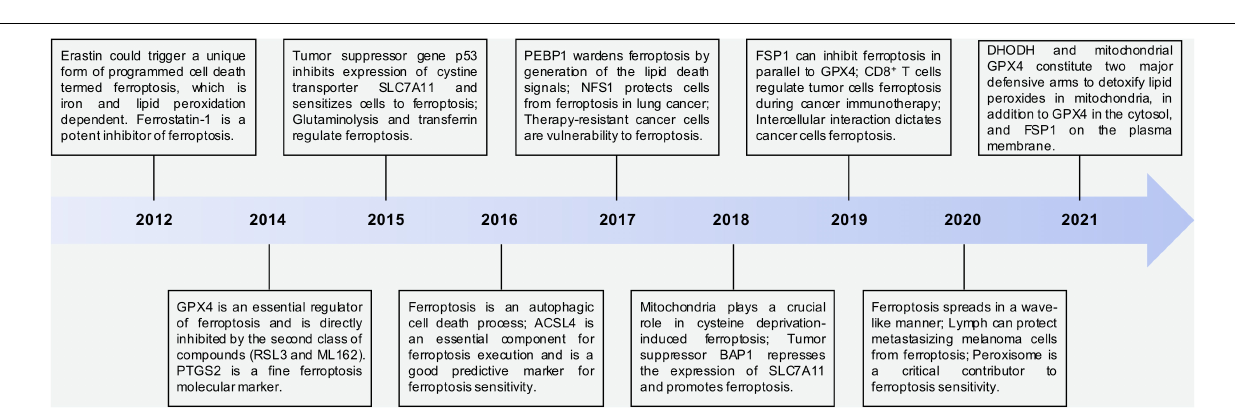
FIGURE 4 | The key points in discovery and research history of ferroptosis. Time line of key findings in ferroptosis research. Ferroptosis was firstly defined in 2012. In this decade, a great number of efforts have contributed to the progression of ferroptosis work. Overall, DHODH and mitochondrial GPX4 are two major defensive arms to detoxify lipid peroxides in the mitochondria, in addition to FSP1 on the plasma membrane and GPX4 in the